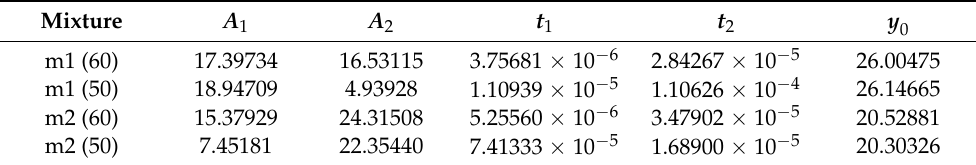
Table 1. The values of the constants of the second order exponential function describing the rela- tionship between the surface tension and the fluorocarbon surfactant concentration (Equation (2)) of CTAB + TX100 + FC1 (m1 (60), m1 (50)) and CTAB + TX100 + FC2 (m2 (60), m2 (50)) mixtures at CTAB + TX100 γ LV equal to 60 and 50 mN/m,